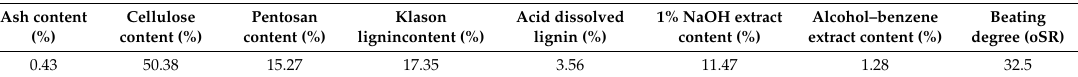
Table 1. Chemical component analysis and properties of poplar APMP